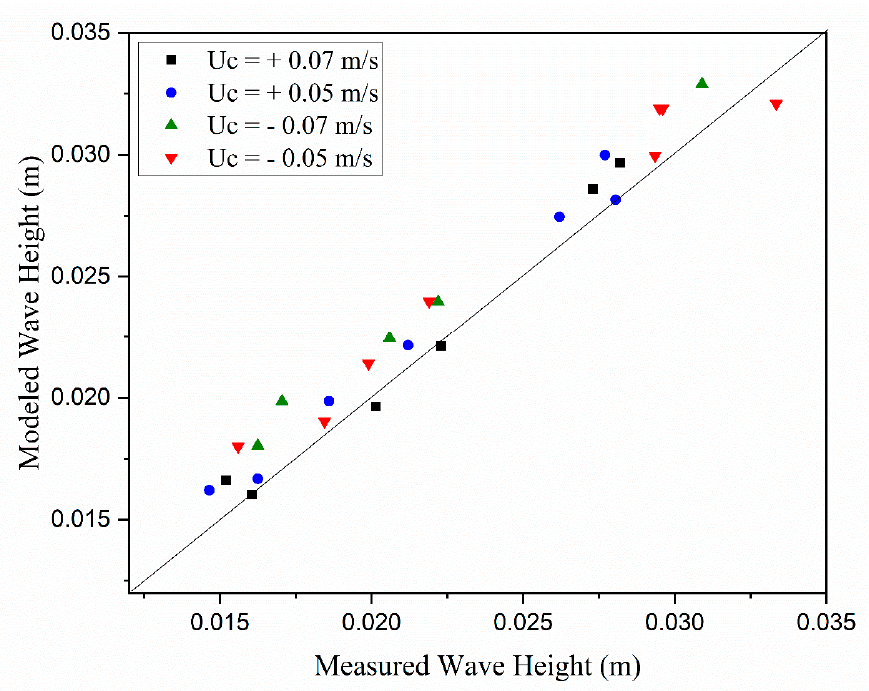
Figure 8. Comparison between measured and modeled values of attenuated wave height for counter and co-currents.